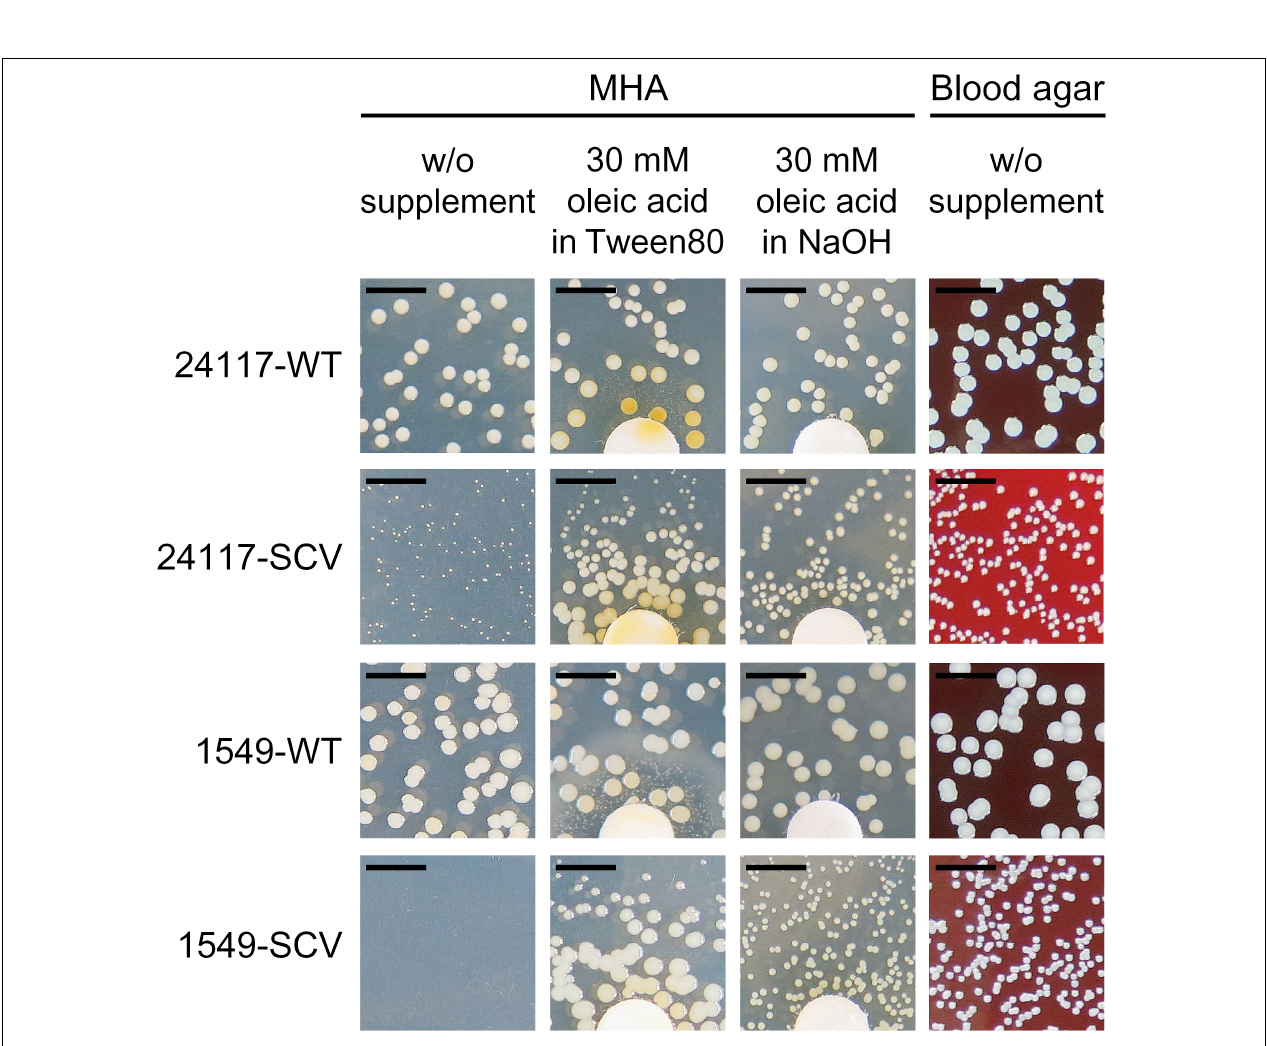
FIGURE 2 | Phenotype of clinical S. aureus strain pairs after 48 h of incubation at 37 ◦ C on MHA with and without supplementation with oleic acid and on Columbia blood agar with 5% sheep blood; scale bar indicates 5 mm; diameter of the discs is 6.4 mm.